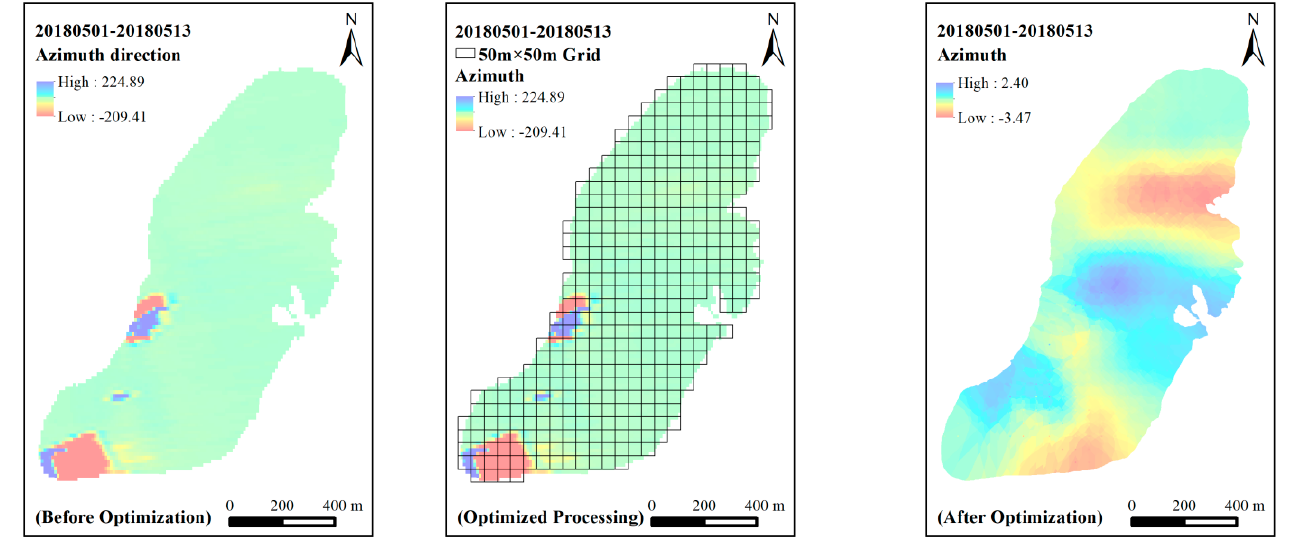
Figure 2. Filter and optimize the offset tracking results (unit: m). (1) A 50 × 50 m grid treatment was carried out on a single glacier, and each grid was checked. When the offset tracking result covered did not exceed 50% of the grid area, the grid was removed. (2) We extracted the average value of offset tracking results covered by each grid after filtering. In order to facilitate subsequent computation, grid data were converted to point data. (3) We obtained the average value a and standard deviation σ of all points on a single glacier and removed the points whose values were outside the threshold a ± 3 σ , then recalculated the average and standard deviation of the remaining point values, and removed the points outside the threshold again, and iterated until all the remaining points fully met the threshold requirements. (4) According to the value of